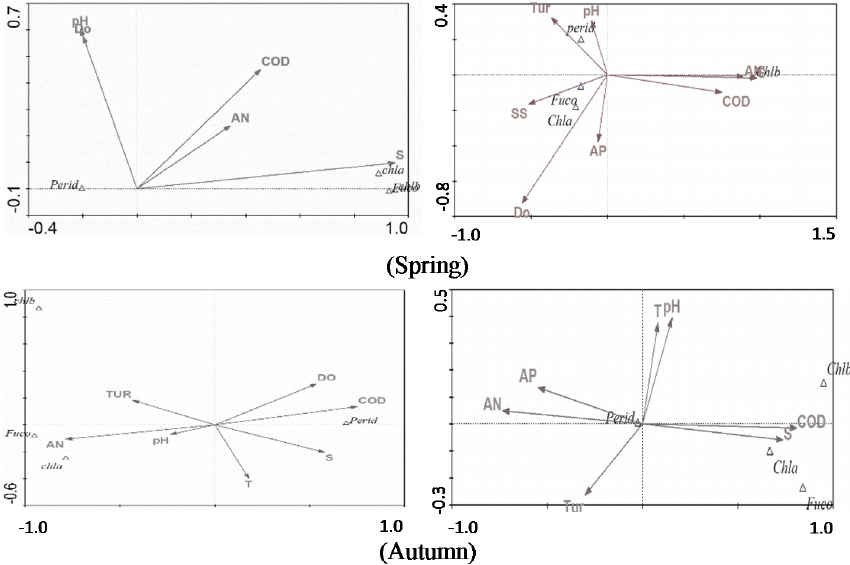
Fig. 2. CCA plots of diagnostic pigments and environmental factors in (a) spring and (b)